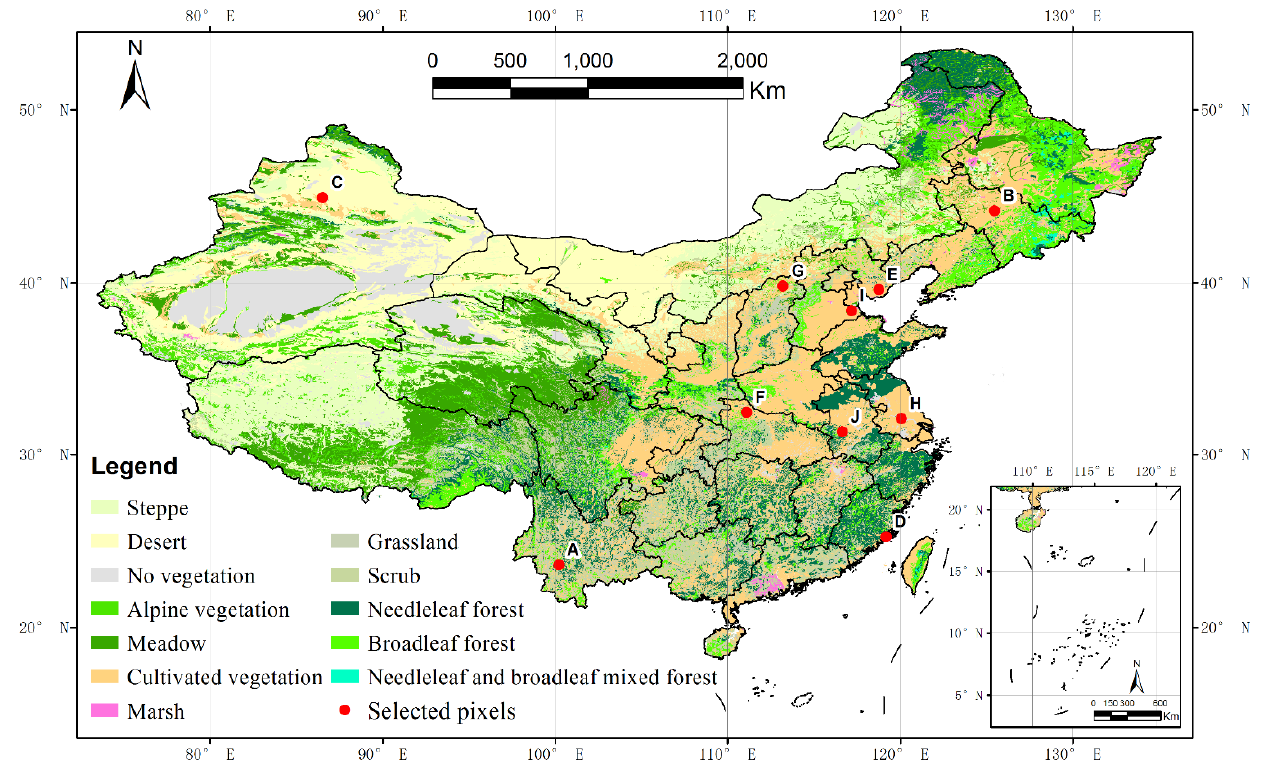
Figure 2. The vegetation map of China and the locations of selected pixels. The vegetation types of selected pixels are following: A-Scrub, B-Cultivated vegetation, C-Desert, D-Needleleaf forest, E-Cultivated vegetation, F-Alpine vegetation, G-Alpine vegetation, H-Cultivated vegetation, I-Cultivated vegetation, J-Needleleaf